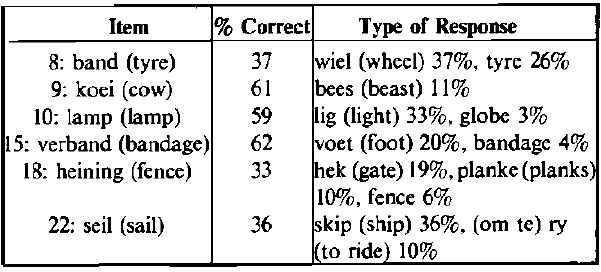
Table 3: Common responses on some of the first 25